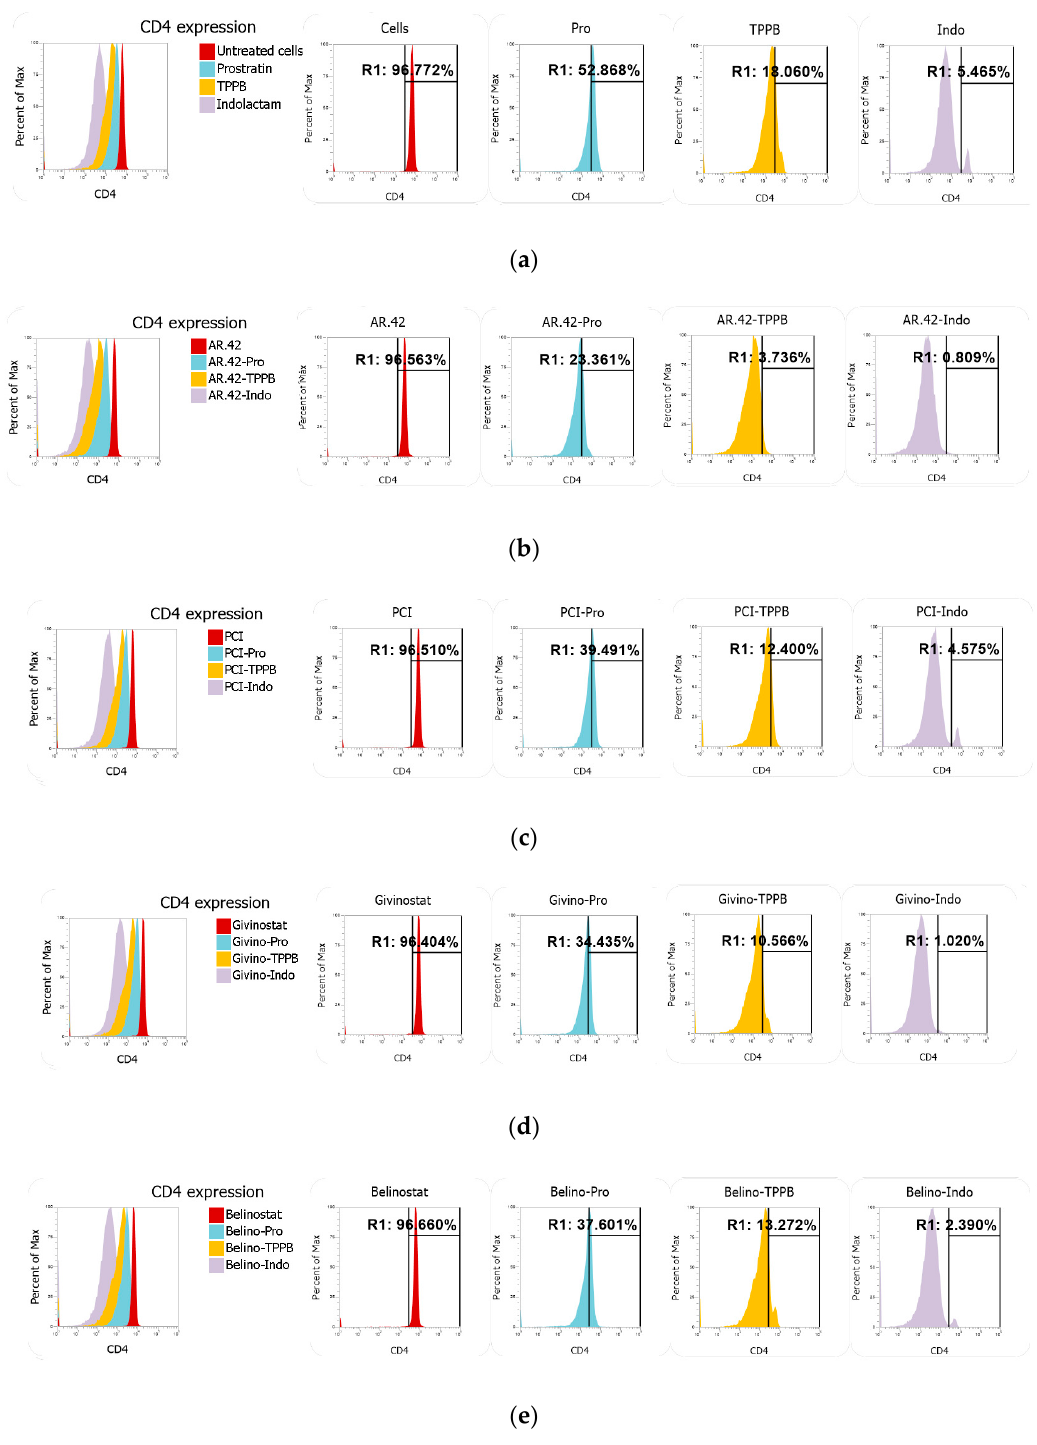
Figure 9. Effect of combinations of LRAs on CD4 expression measured using flow cytometry. Total CD4 + T-cells were stained with anti-CD4 and anti-CD3 following treatment with LRAs for 24 h. ( a ) Representative overlay and single peaks of CD4 expression of untreated cells and cells treated with prostratin, TPPB, and indolactam. ( b ) Overlay and single peaks of CD4 expression of cells treated with AR-42 alone and in combination with PKCas. ( c ) Overlay and single peaks of CD4 expression of cells treated with PCI alone and in combination with PKCas. ( d ) Overlay and single peaks of CD4 expression of cells treated with givinostat alone and in combination with PKCas. ( e ) Overlay and single peaks of CD4 expression of cells treated with belinostat alone and in combination with